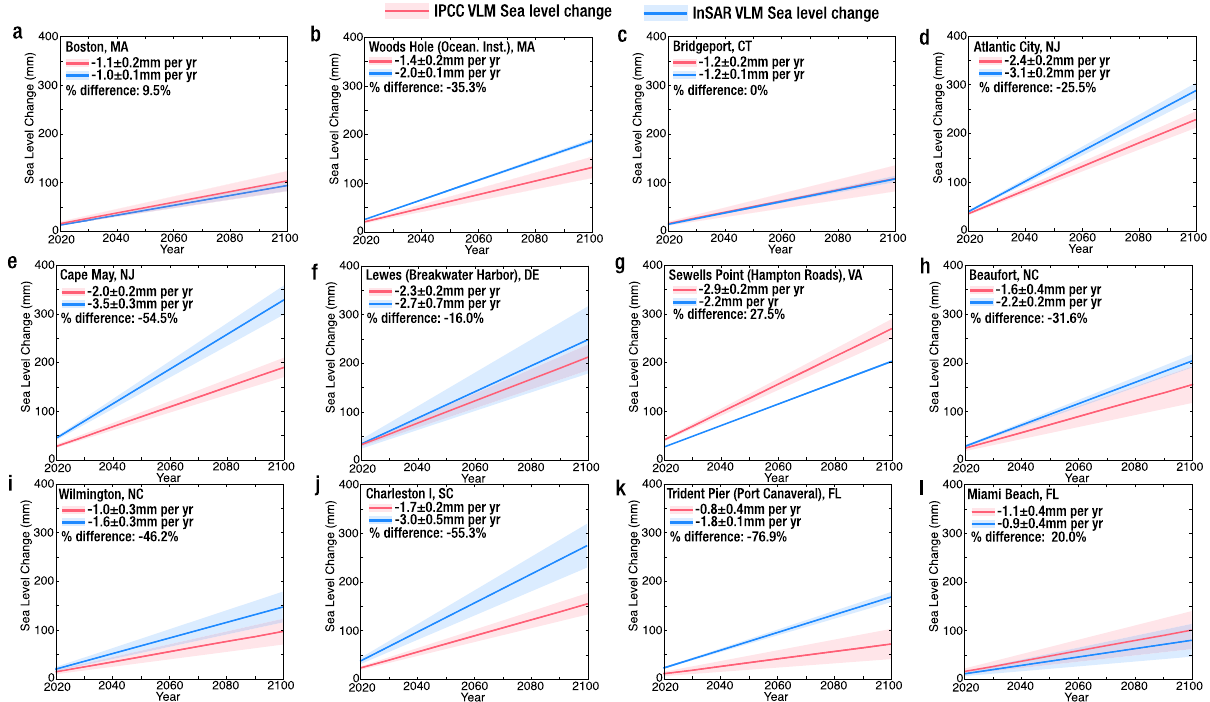
Fig. 3 | Sea-level change due to vertical land motion (VLM). Comparison of sea- level change (millimeters) due toverticalland motion from IPCCSixth Assessment Report 56,57 withsea-levelchange(millimeters)usingVLMestimatefromthisstudyat 12 tide gauge stations. a Boston, Massachusetts (MA), b Woods Hole, MA, c Bridgeport, Connecticut (CT), d Atlantic City, New Jersey (NJ), e Cape May, NJ, f Lewes, Delaware (DE), g Sewells Point, Virginia (VA), h Beaufort, North Carolina (NC), i Wilmington, North Carolina (NC), j Charleston I, South Carolina (SC), k Trident Pier, Florida (FL), l Miami Beach, FL. The solid red line shows the IPCC